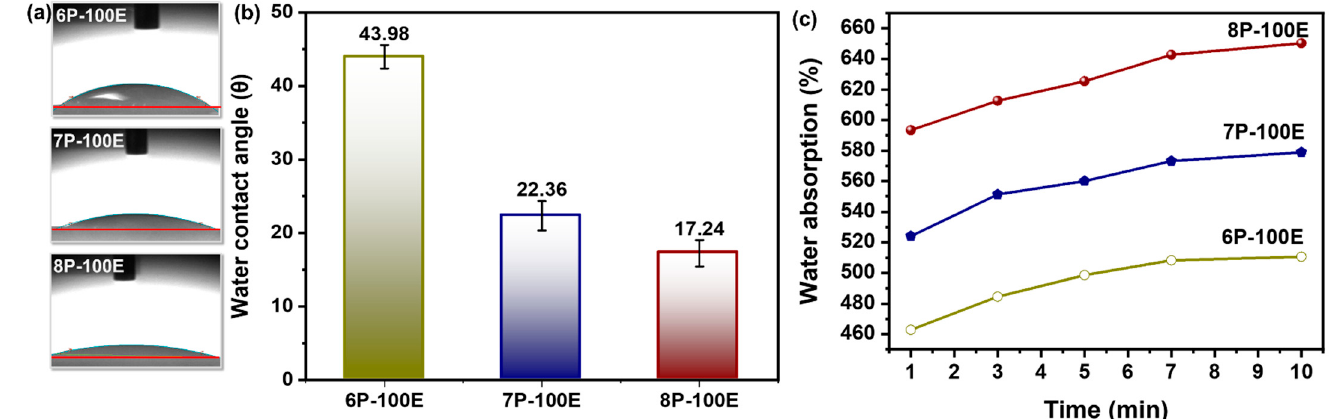
Figure 6. Hydrophobicity attributes of the developed nanofiber sheet ( a , b ) water contact angle through sessile drop method and its relation with PVA concentration with constant AI /water ratio 100:0 ( c ) water absorption rate of PVA nanofiber fabricated at 6, 7, and 8 wt% PVA with constant AI /water ratio 100:0.